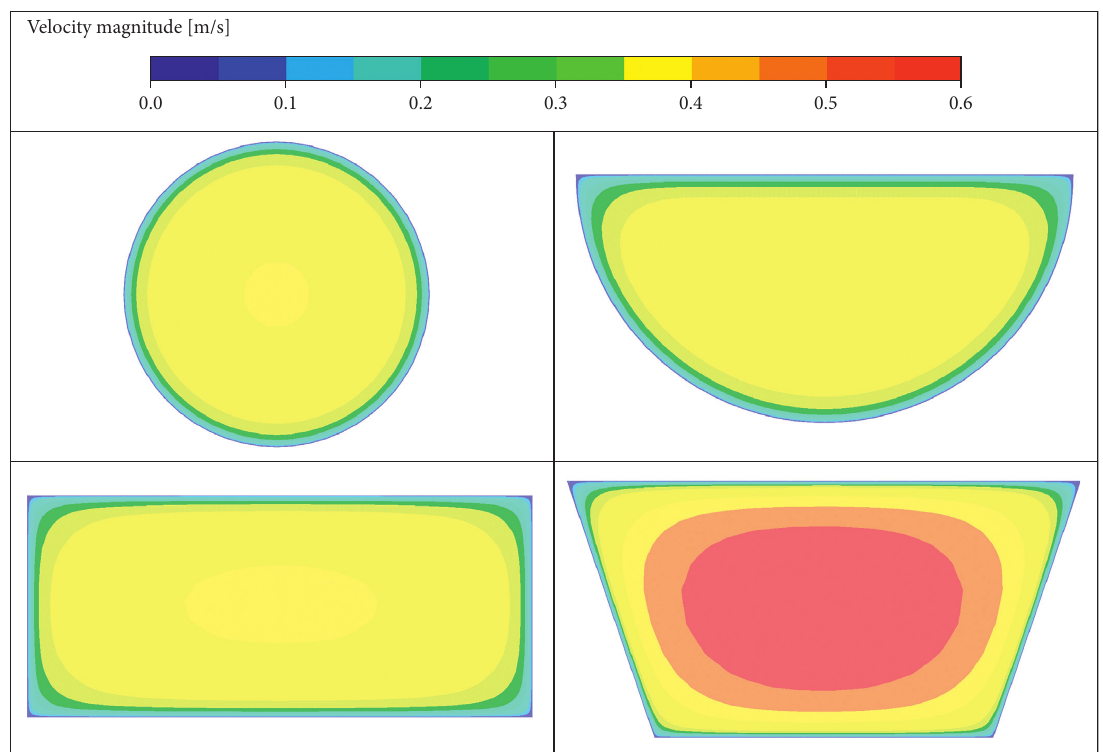
of the cooling Δ P